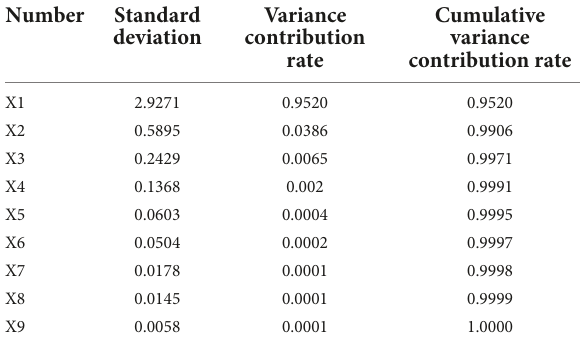
TABLE 2 Principal component analysis (PCA) results of factors affecting the taxation of ceramic